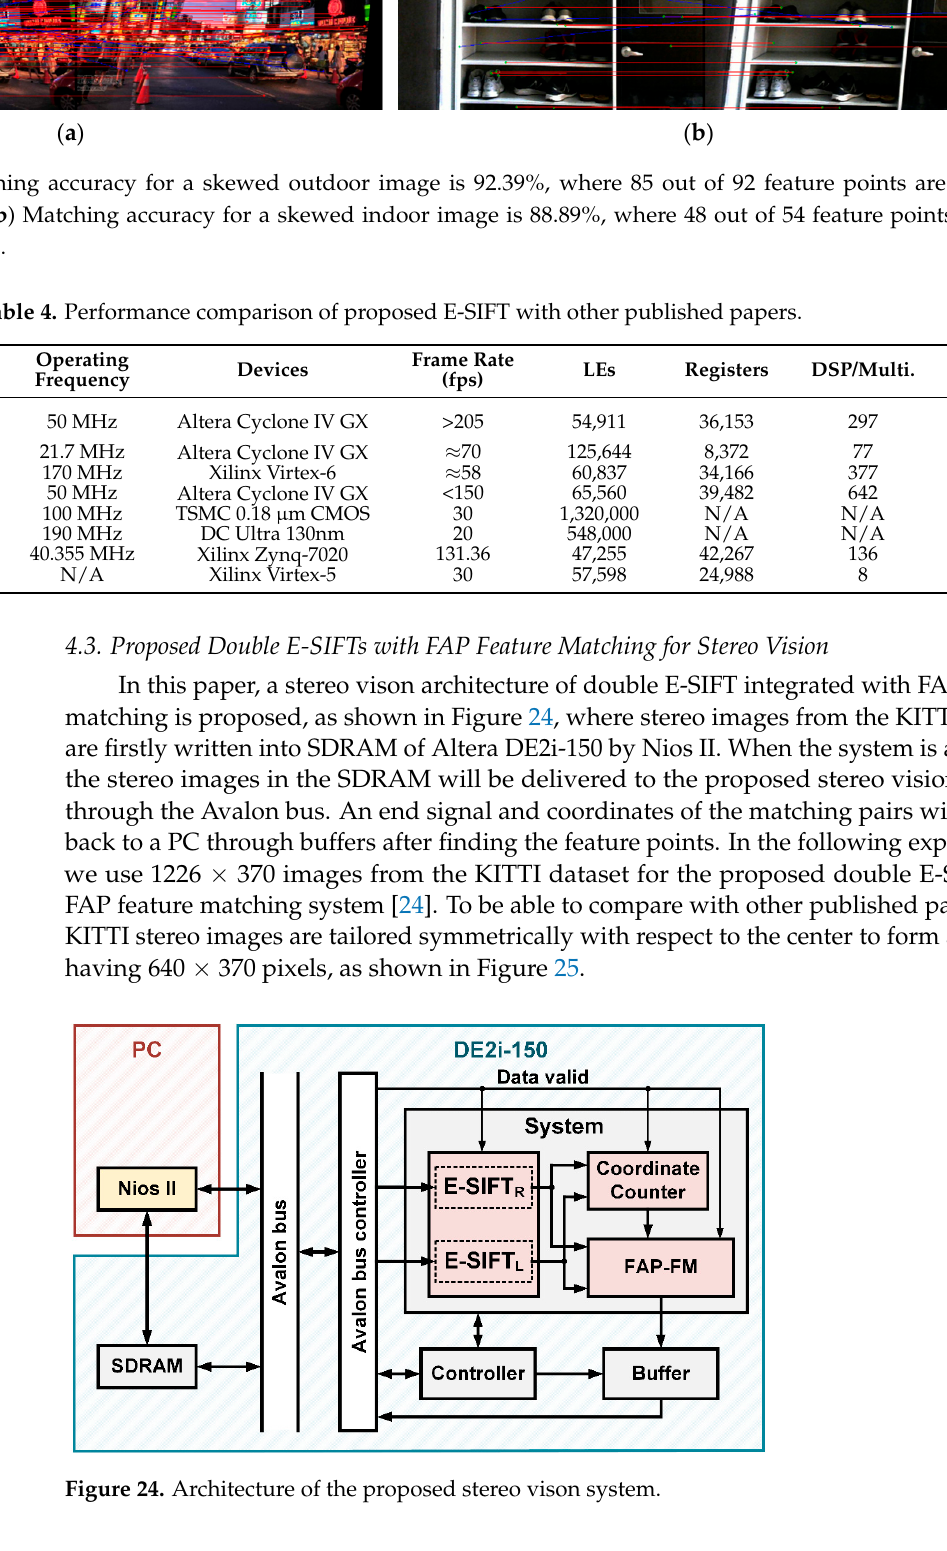
Figure 25. Image tailored from KITTI dataset. When stereo images 00 02566.png from KITTI dataset having a car in the street are applied respectively to the left and right E-SIFTs, more feature points, i.e., 2162 and 1972 in the left and right images, can be detected, as shown in Figure 26b. Note that there are 102 and 110 feature points around the car in the left and right images, respectively. After the FAP feature matching, we obtain 560 matching pairs where 44 are for the car. Both the above-mentioned experiments of stereo visions present sufficient matching points for the purpose of mapping or object tracking. To evaluate the accuracy of the proposed double E-SIFT with FAP feature matching, the stereo images are aligned vertically, where green matching lines are depicted with the same procedure, as shown in Figure 27a,b. The ac- curacy of the proposed double E-SIFT with FAP feature matching presents good results because there are no apparent skewed matching lines existed in the images. Table 5 shows the consumed hardware resources of the proposed double E-SIFT with FAP feature matching for stereo vision. The usage ratios of LEs, registers, RAM, and DSP/Multiplier in the DE2i-150 development board are 93.6%, 52.4%, 82.5%, and 8.9%, respectively. For the whole system, the double E-SIFT and the FAP feature matching oc- cupy 76% and 24% of LEs, respectively, as shown in Figure 28a. Most of the registers, about 90%, are used by the E-SIFTs. Only 10% of the total register devices are used by the FAP feature matching, as shown in Figure 28b. The usage ratio of the coordinate counter is very low and can be neglected. The total power consumption of the FPGA when it hosts the proposed architecture including the double E-SIFT and the FAP feature matching is less than 1168.33 mW. This value is estimated using the Power Analyzer from Intel [25]. It is difficult to directly meas- ure the power consumption because the DE2i-150 development board that we used to